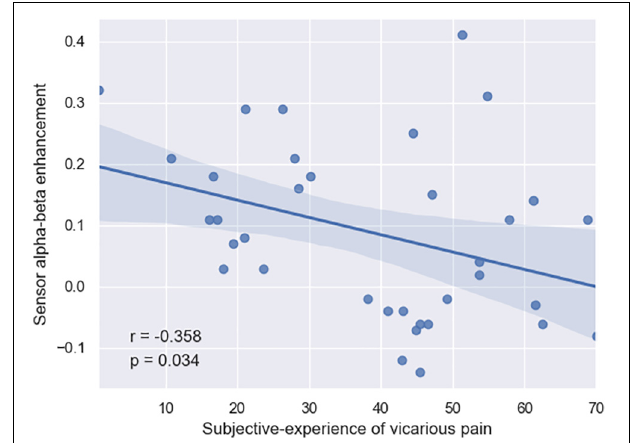
FIGURE 3 | Negative correlation between the subjective experience of subjects and their late alpha-beta power enhancement in the brain ( r = –0.358, p =